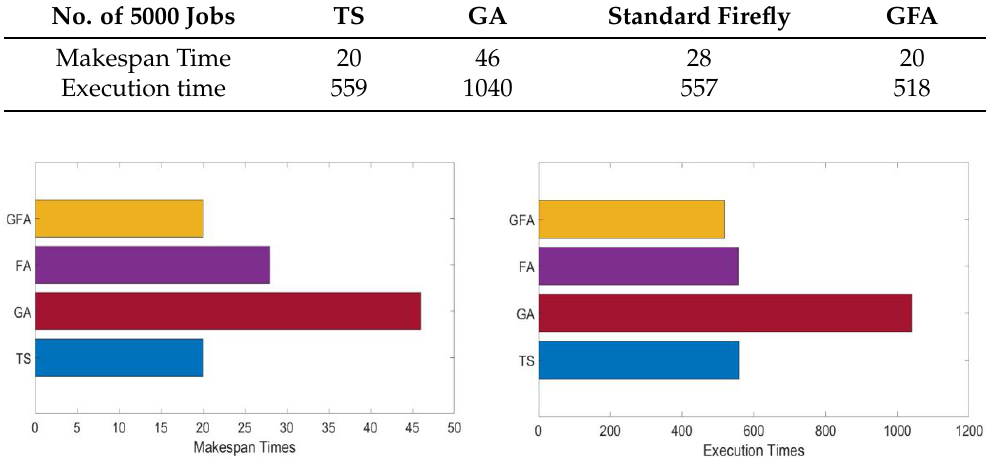
Figure 11. Makespan and Execution times for Lightweight